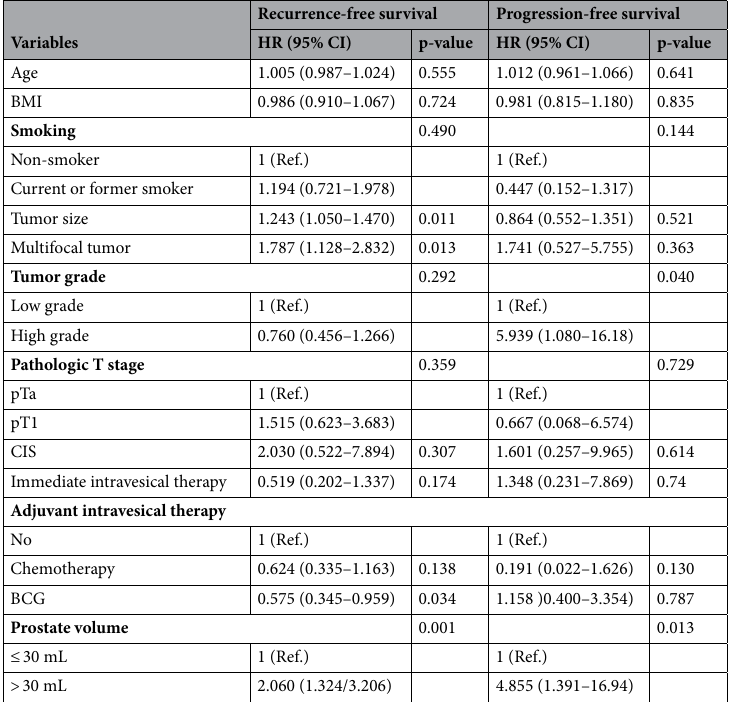
Table 3. Multivariable analyses of factors associated with recurrence-free survival and progression-free survival with propensity score matched cohort. HR hazard ratio, BMI body mass index, CIS carcinoma in situ, BCG bacillus